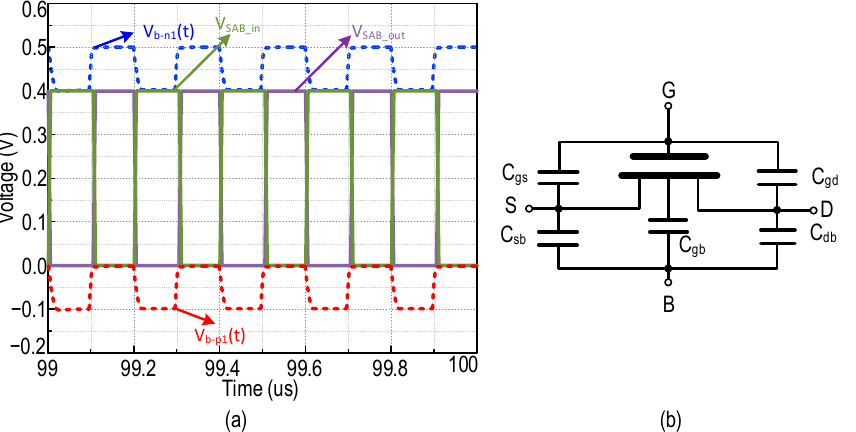
Figure 8. ( a ) Simulated waveform of the output voltage (V OUT ) of the single-stage SAB-RVCO scheme ( b ) MOSFET parasitic capacitances